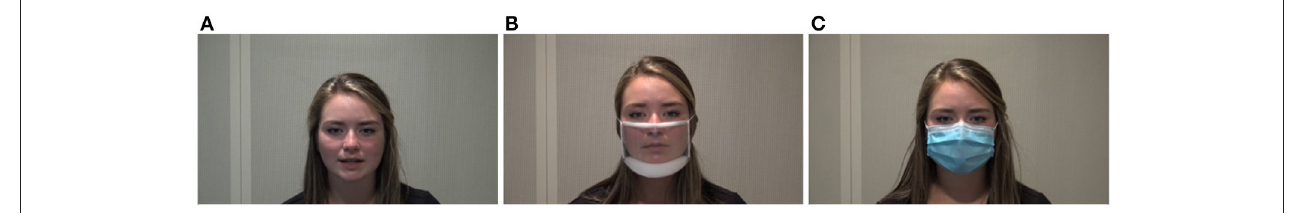
FIGURE 1 | Face mask conditions including (A) no mask, (B) transparent mask, and (C) disposable face mask.